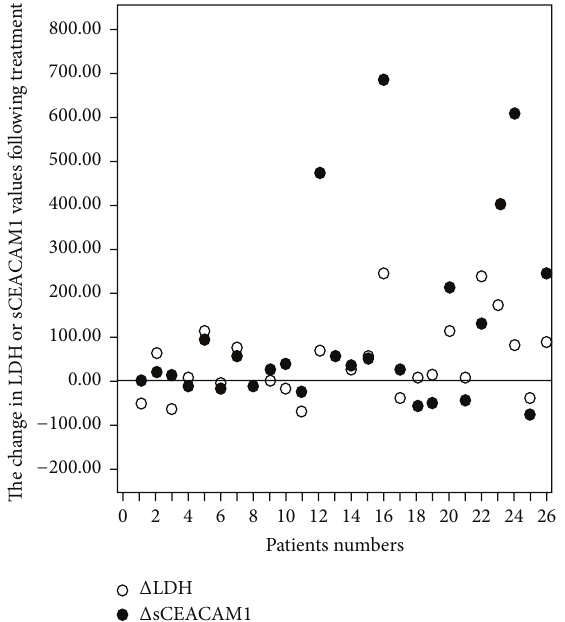
Figure 5: The changes in serum CEACAM1 in patients responding to treatment correlate with those in LDH. sCEACAM1 and LDH levels were tested at the same time points before and following immunotherapy for 26 AJCC stage IV patients. The baseline, pretreatment levels of sCEACAM1 (or LDH) were then subtracted from posttreatment levels and plotted as black (sCEACAM1) or white (LDH) circles for each of the